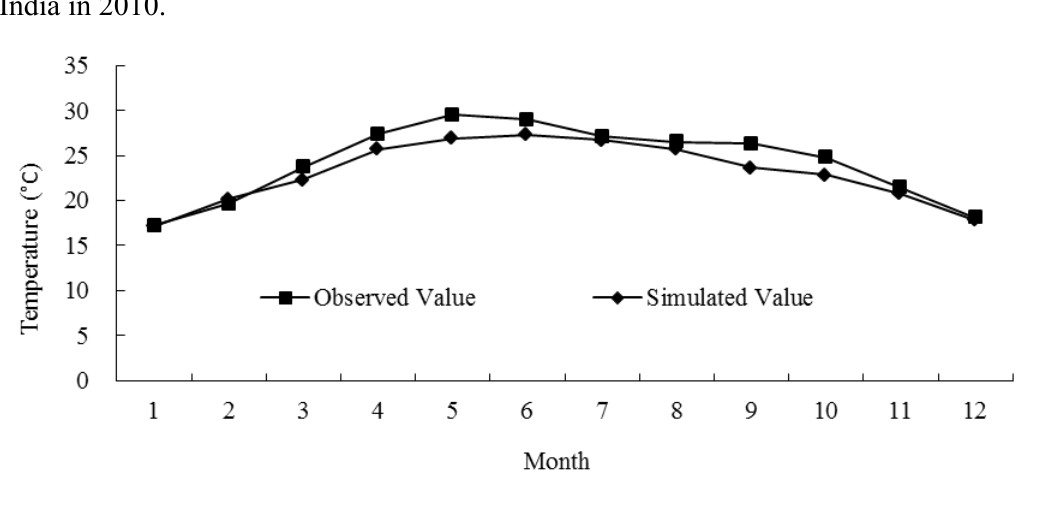
Figure 4. Simulated and observed values of the monthly average near-surface temperature of India in